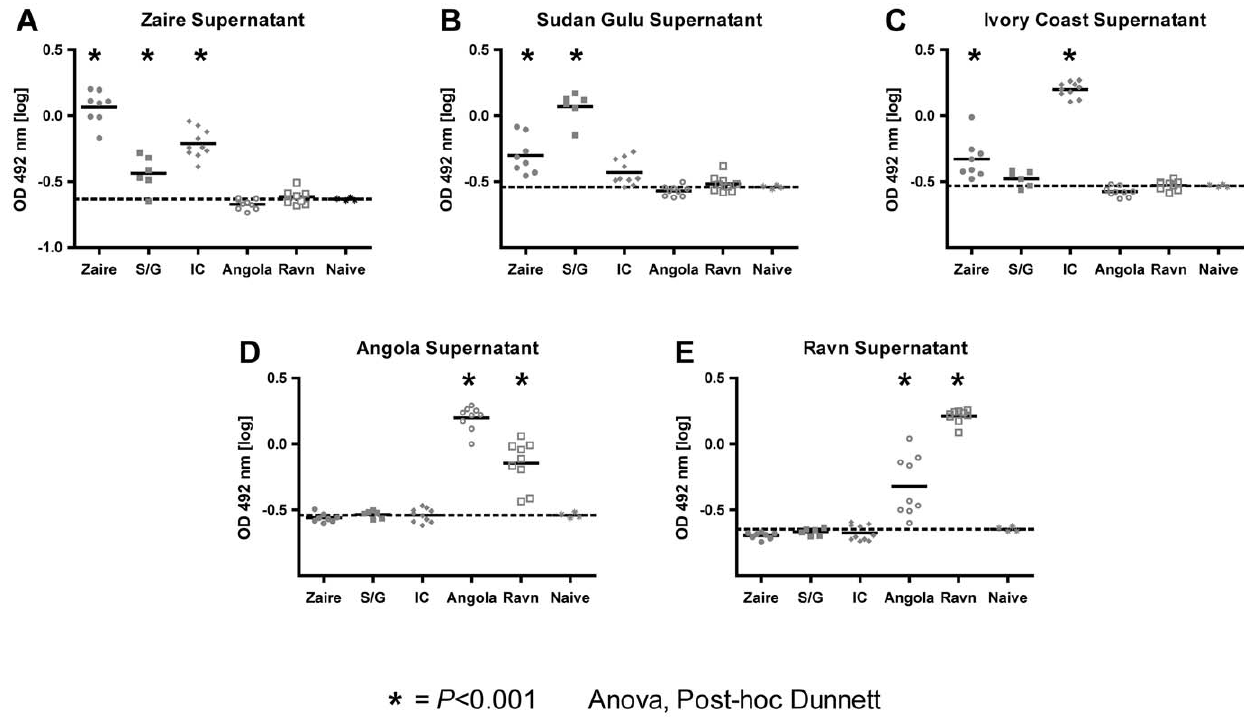
Figure 2. Cross reactivity of the elicited humoral immune response. The humoral immune response was detected by ELISA in serum isolated from mice either vaccinated with 10 10 vp of rAd26 or rAd35 coding for the glycoprotein of one of the five filovirus strains. Serum from 10 mice vaccinated against one of five filovirus strain was probed against ELISA plates coated with either Ebola Zaire (A), Ebola Sudan Gulu (B), Ebola Ivory Coast (C), Marburg Angola (D), or Marburg Ravn (E) glycoprotein-containing supernatant. Naı¨ve serum from five mice each was used as control and the average of these is represented as a dotted line. The bar represents the mean of the log transformed OD and the grey balls an individual mouse each. The star indicates a significant difference from the negative control (p , 0,001, Anova, Post-hoc